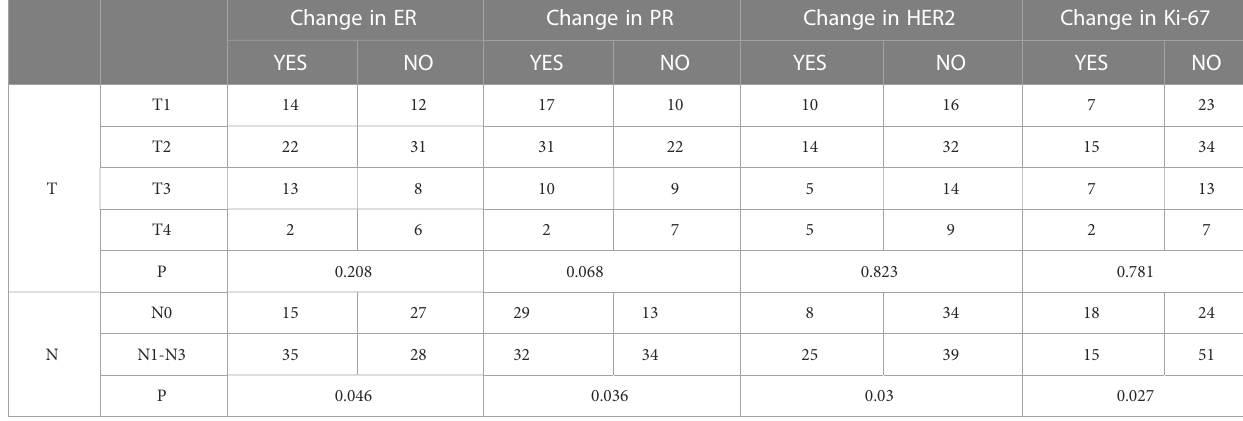
TABLE 3 Correlation between T, N, and the expression changes of immunohistochemical indexes. Change in ER Change in PR